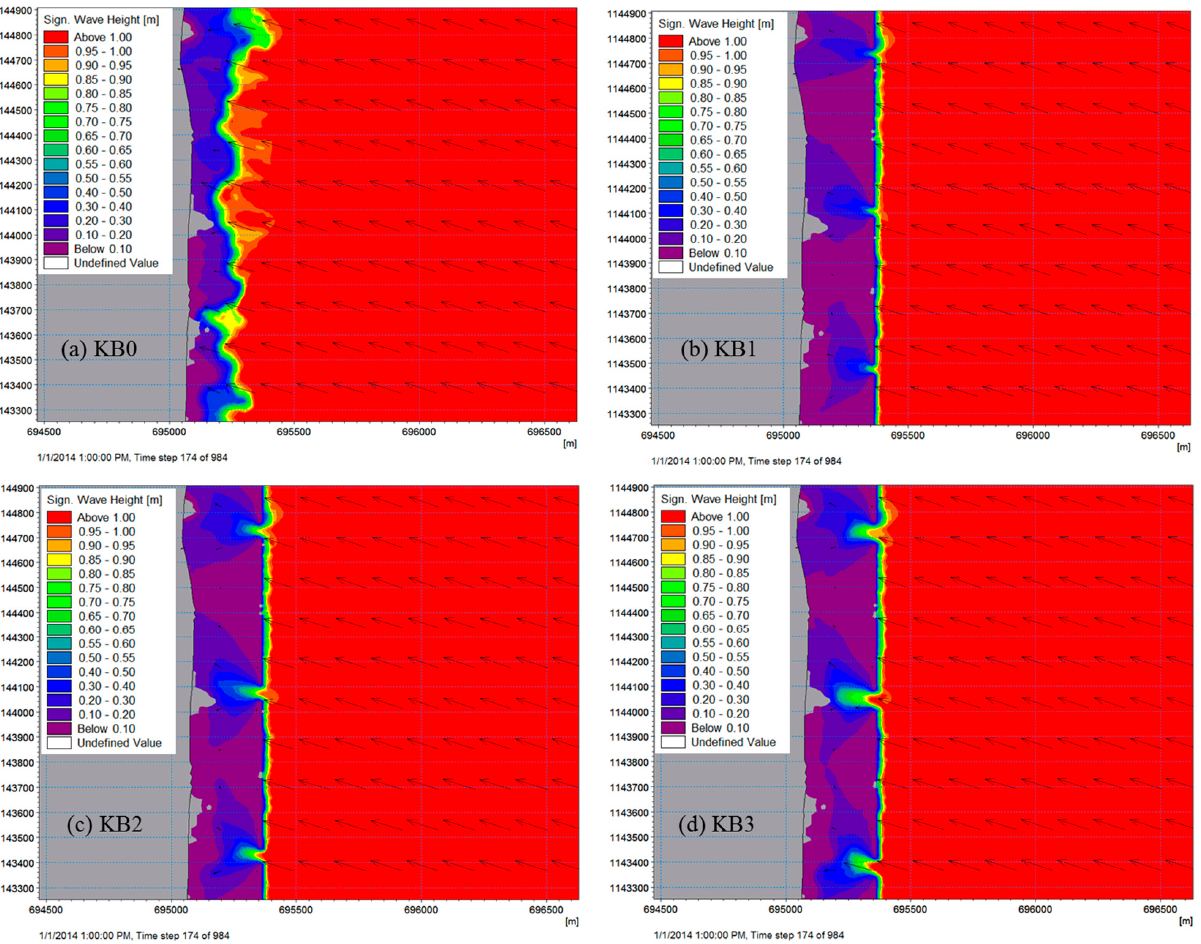
Figure 12. The NE monsoon wave fields by MIKE21 FM for scenarios (baseline—KB0, KB1, KB2, KB3) at the highest wave height.